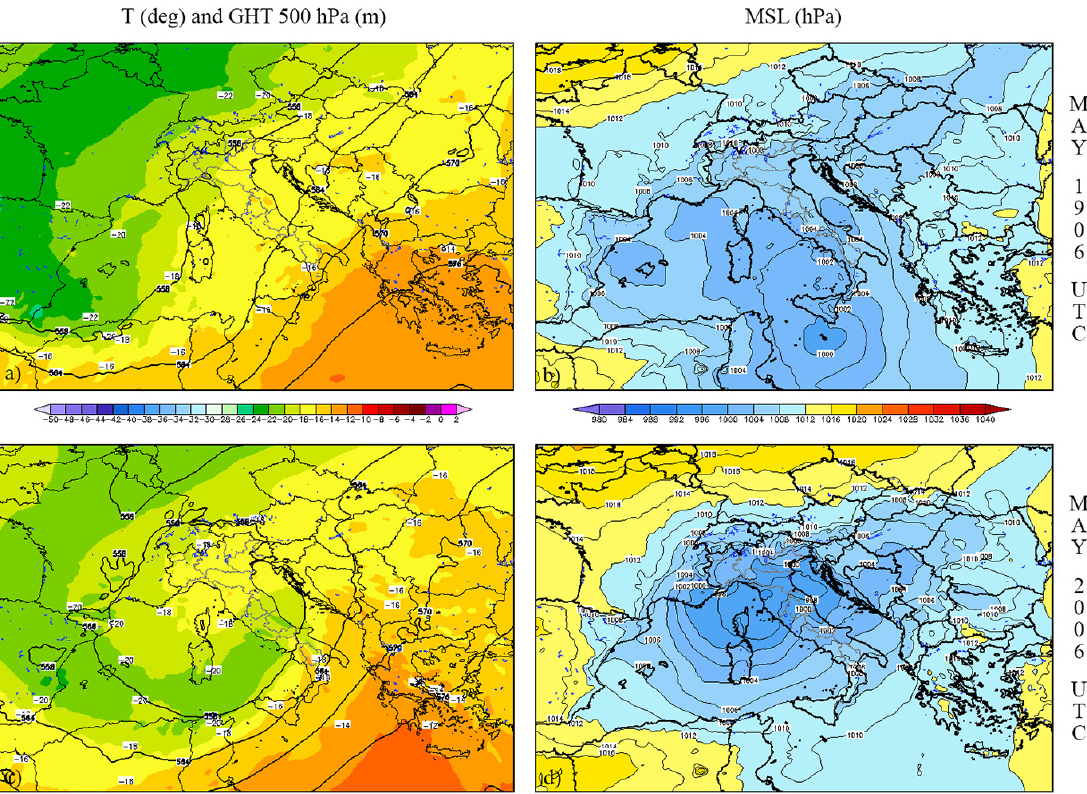
Figure 1. European Center for Medium-Range Weather Forecasts (ECMWF) analyses at 06:00UTC on 19 May 2008: (a) temperature and geopotential height, at 500hPa, and (b) mean sea level pressure and surface wind in ms − 1 ; ECMWF analyses at 06:00UTC on 20 May 2008: (c) temperature and geopotential height, at 500hPa, and (d) mean sea level pressure and surface wind in ms − 1